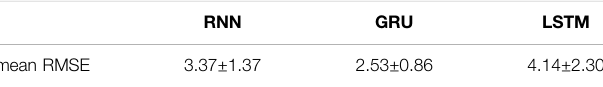
TABLE 1 | Result of TOFR temporal sequence prediction. Mean value ± std (standard deviation) was